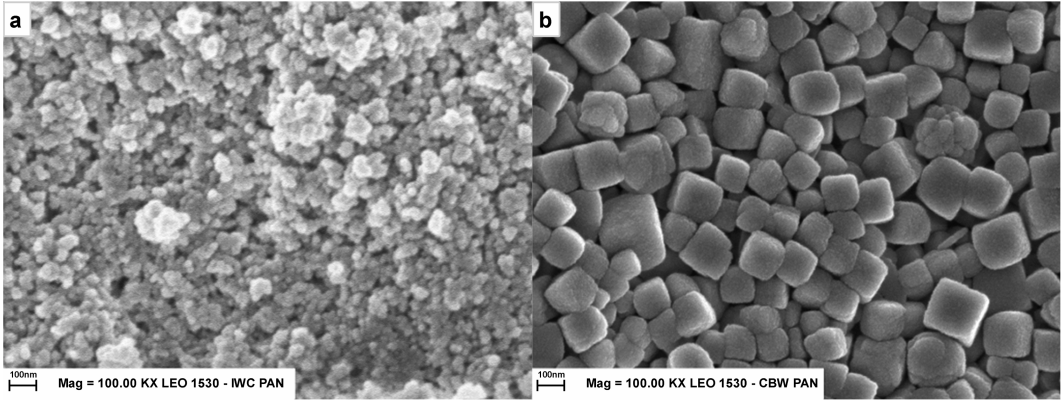
Figure 3. Comparison of aggregation for nano-YAG powder produced using ( a ) the precipitation method followed by calcination at 1100 °C and ( b ) solvothermal process at 450